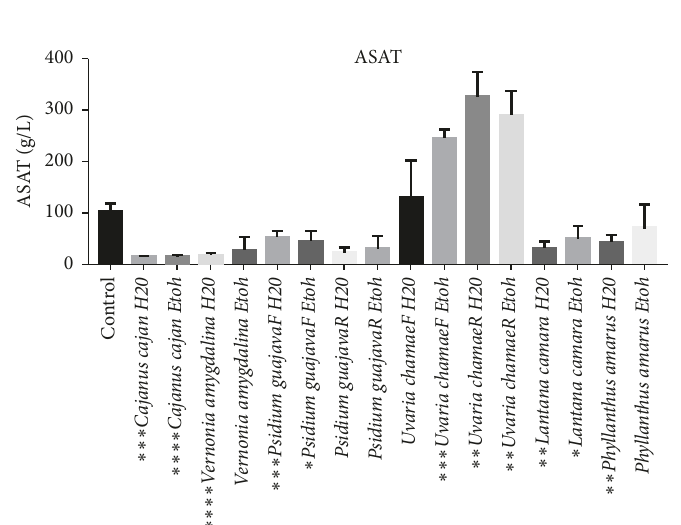
Figure 2: Effects of extracts on creatinine.